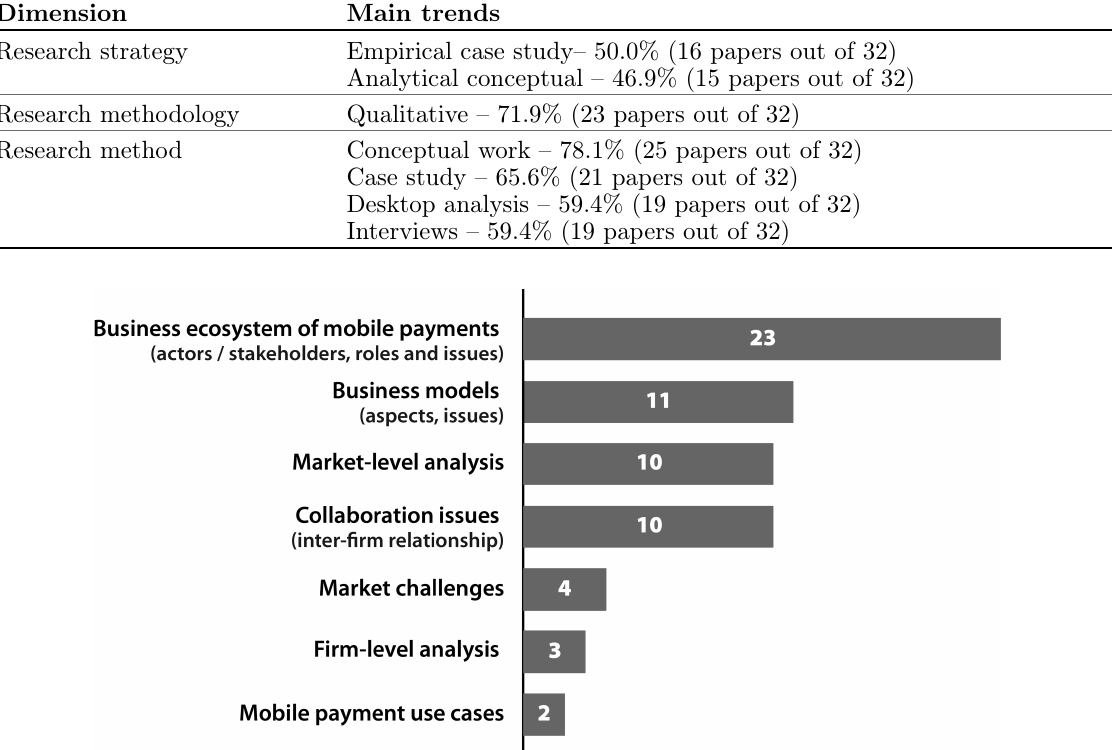
Fig. 7. Classification of papers on business aspects by